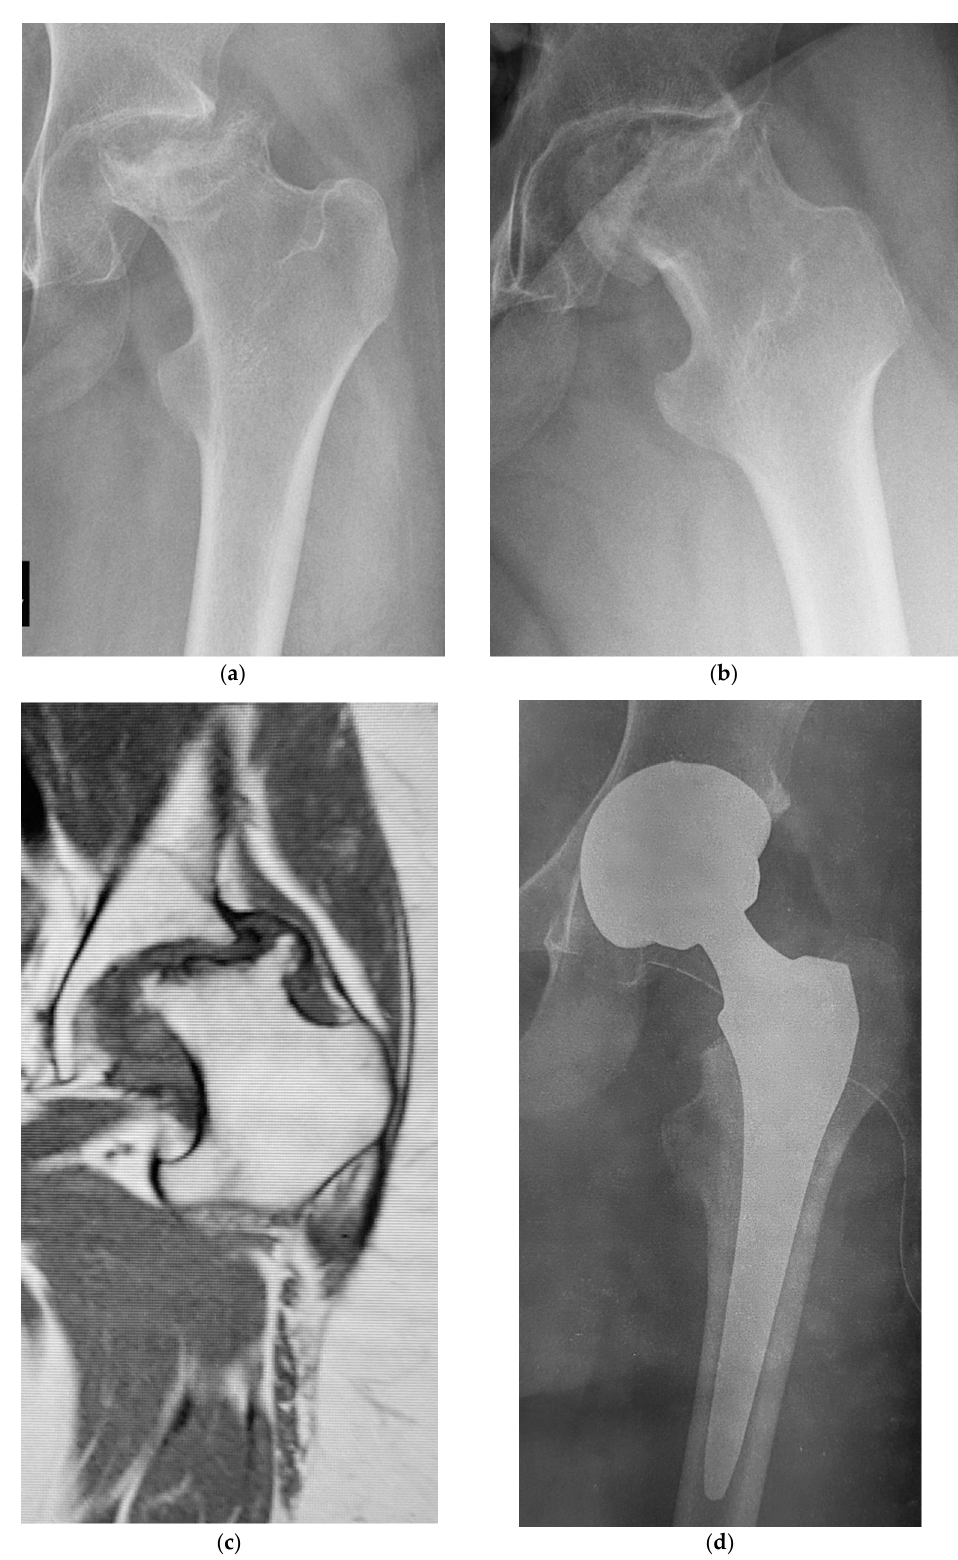
Figure 1. Female, 14 years old, osteonecrosis of the femoral head in her left hip: preoperative radiological features in AP ( a ), axial view ( b ) and magnetic resonance imaging ( c ). Postoperative AP X-ray ( d ) of THA with a 32 mm AMC-on-AMC coupling.